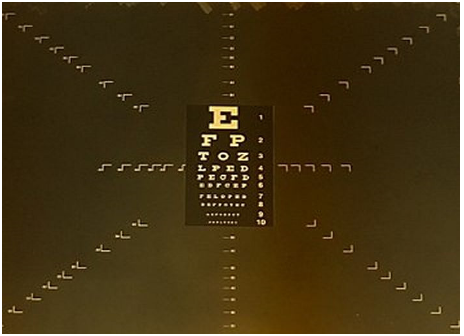
Figure 1. Miniaturized visual Snellen optotype (under magnification ×4) by courtesy of the Croatian State Archive .